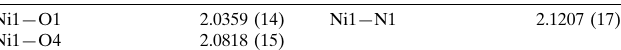
Selected bond lengths (A˚ ).